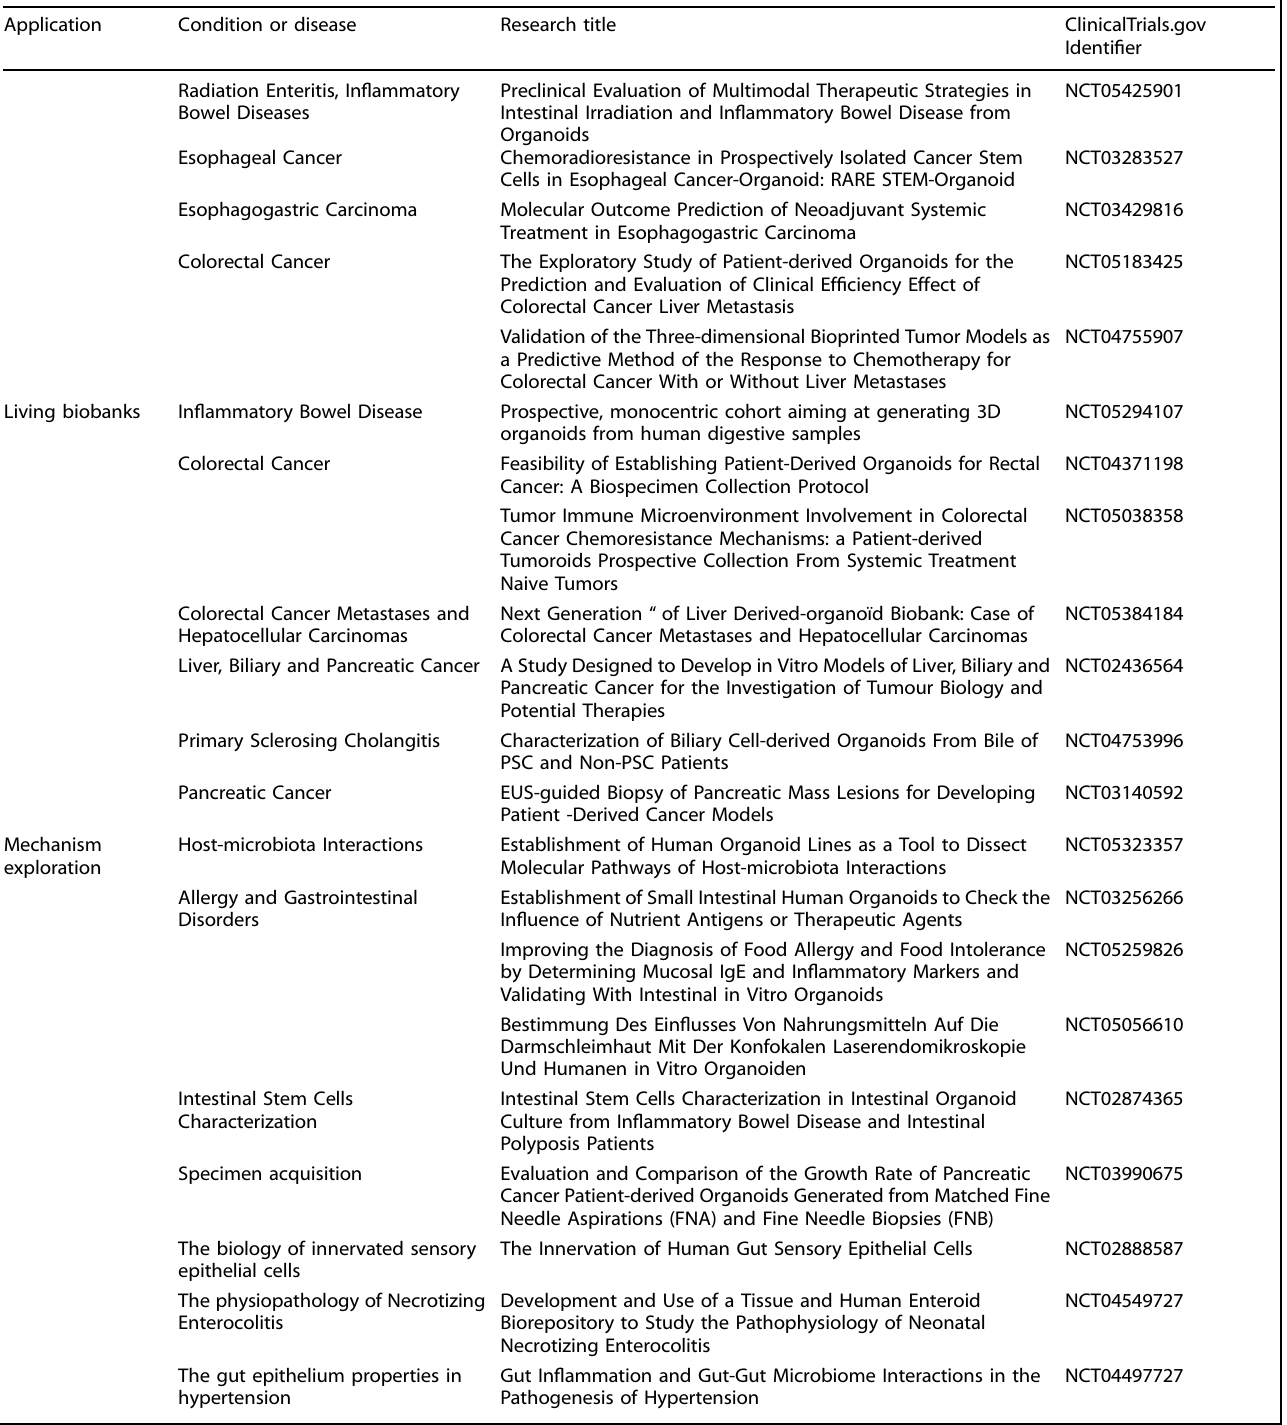
bowel syndrome, lack suitable disease models 462 and the emergence of organoids provides new research ideas. By constructing organoids to simulate the intestinal environment, researchers can explore the interaction between the intestinal system and the outside factors, explore the pathophysiological mechanisms and formulate treatment strategies.